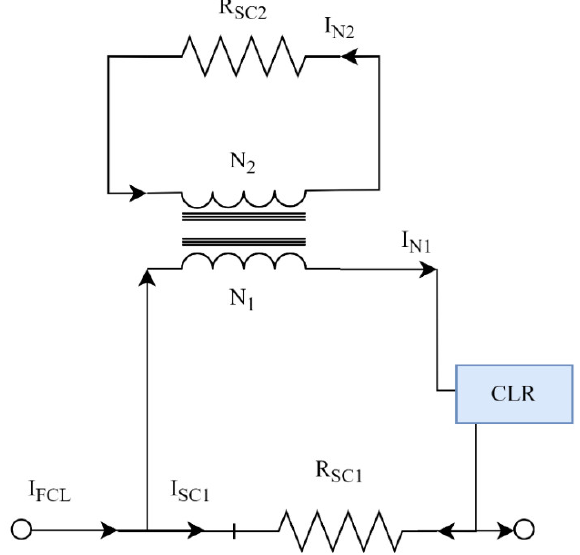
Figure 6. DC SFCL using a